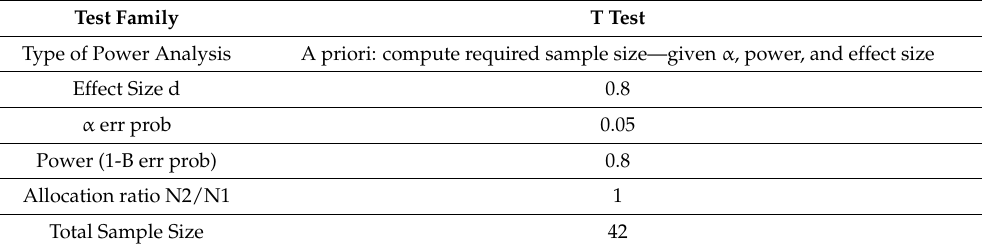
Table 1. Detailed data values for calculating the number of